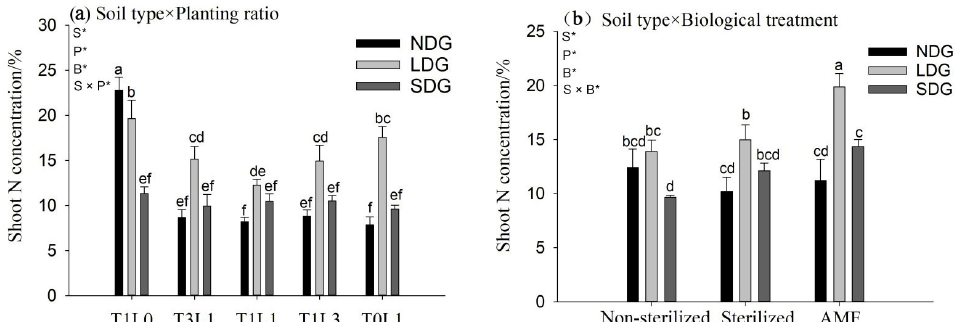
Figure 3. Effects of different treatments on shoot N content. ( a ) Effects of soil type (S), planting ratio (P) and their interactions (S × P) on shoot N concentration. ( b ) Effects of soil type (S), biological treatment (B) and their interactions (S × B) on shoot N concentration. Different letters indicate the significant differences among treatments ( p < 0.05). * p < 0.05, p < 0.1 indicate the significance level of each treatment. Note: soil degradation degree (S); planting ratio (P); soil biological treatment (B); NDG: non-degraded grassland; LDG: lightly degraded grassland; SDG: severely degraded grassland. T1L0, T3L1, T1L1, T1L3, T0L1 mean planting ratio of T. repens and L. perenne : 1:0, 3:1, 1:1, 1:3, 0:1, respectively.